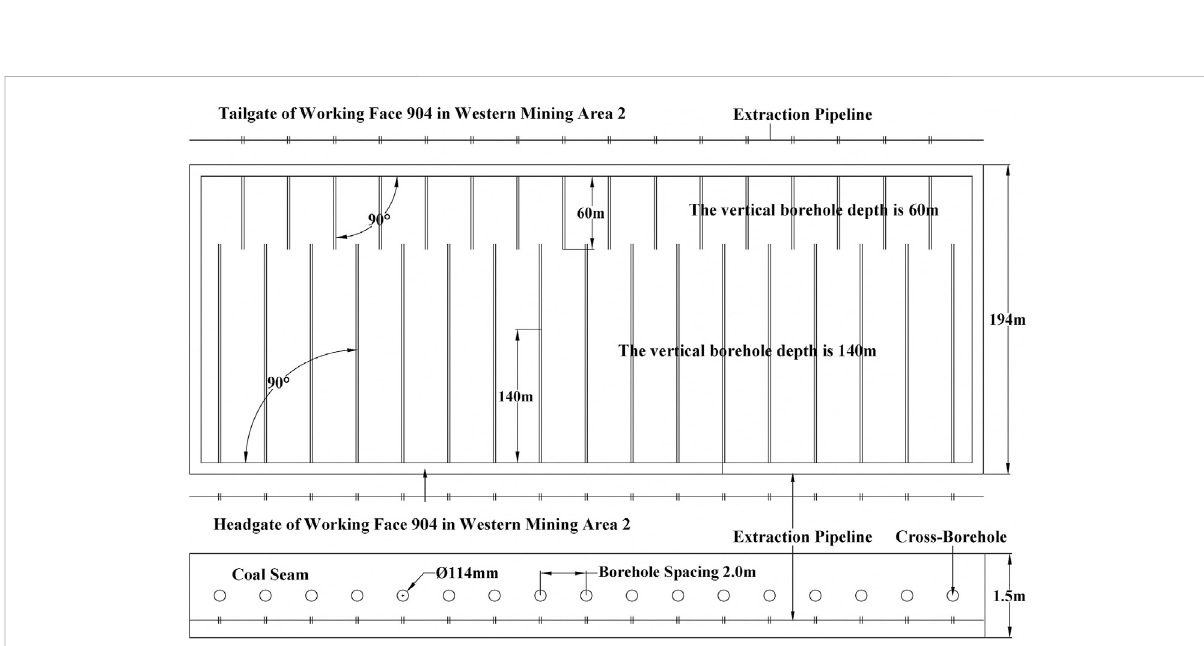
FIGURE 7 The 904 working face gas extraction borehole optimization layout